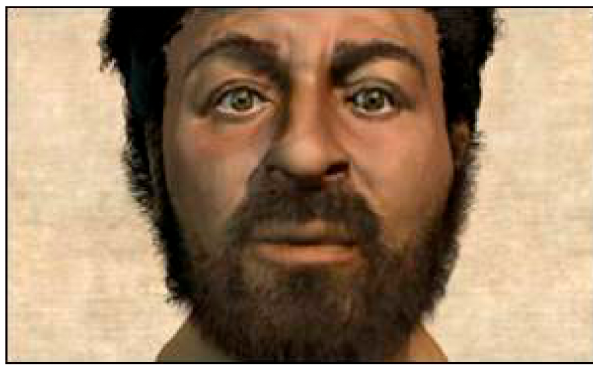
Figure 7. Image of Jesus constructed in BBC documentary, Son of God